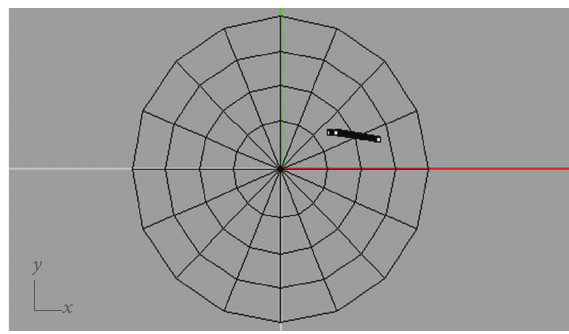
Figure 10: Top view of the simple reflection points obtained with function (7).